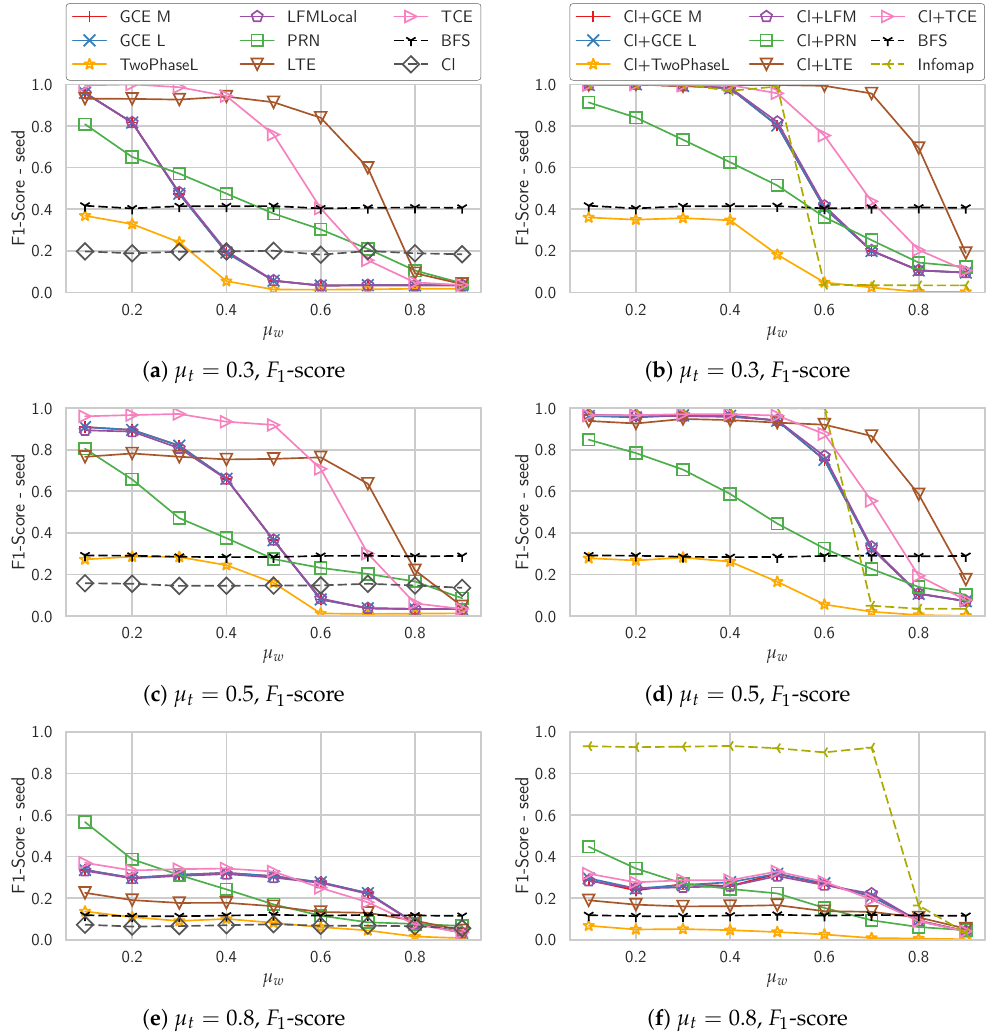
Figure 4. Avg. F 1 -scores on the LFR benchmark with the parameter set Weighted, as specified in Table